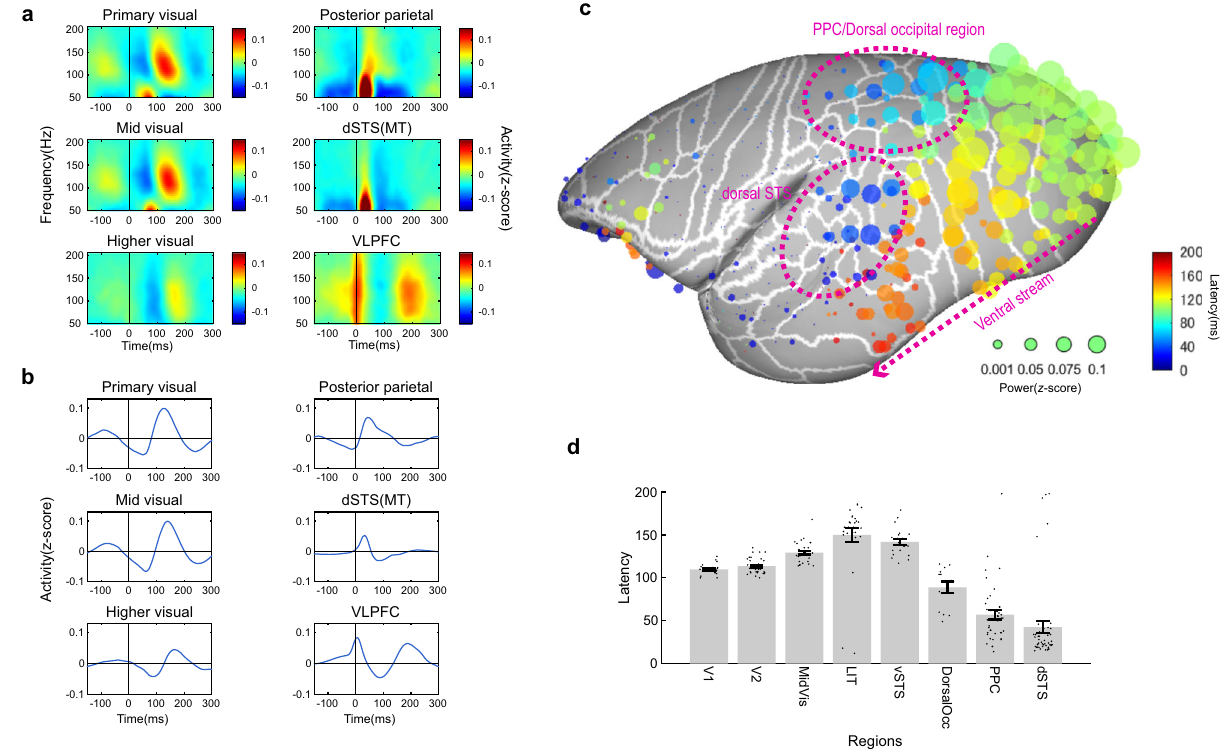
Fig. 2 Perisaccadic activation pattern of active vision. Post-saccadic neural activity of whole electrodes. a ECoG perisaccadic spectrogram of representative electrodes. The ECoG signals were aligned by saccade onset. Robust activity can be seen in visual areas after saccades. b High-gamma (100 – 160 Hz) ECoG signals in representative channels. c The magnitude and latency of the high-gamma signal peak from saccade onset. The data from four animals and 96 × 4 channels distributed over the entire lateral cortex (63 cortical areas) are plotted. The electrodes on the right hemisphere are computationally mapped onto the left hemisphere for visualization purposes. The smooth transition of visual information can be seen in the ventral stream. The areas in the dorsal stream (such as the dSTS including the MT, PPC, and dorsal occipital areas) were activated prior to the ventral stream. Statistical assessment of signal modulation by randomization is shown in Supplementary Fig. 1. d Mean latency of post-saccadic neural activity in each cortical region. Error bars showed standard error of the mean. Dots show individual electrodes. MidVis mid-visual areas (e.g., V3, TEO), LIT lateral inferior temporal areas (e.g., TE1, TE2), vSTS ventral superior temporal sulcus (e.g., PG/IPa, vFST), dSTS dorsal superior temporal sulcus (e.g., MST, MT, dFST), DorsalOcc. dorsal occipital areas (e.g., V6, V3a), PPC posterior parietal cortex (e.g., LIP, AIP, Opt). Supplementary Table 1 shows detailed area names included in each region of